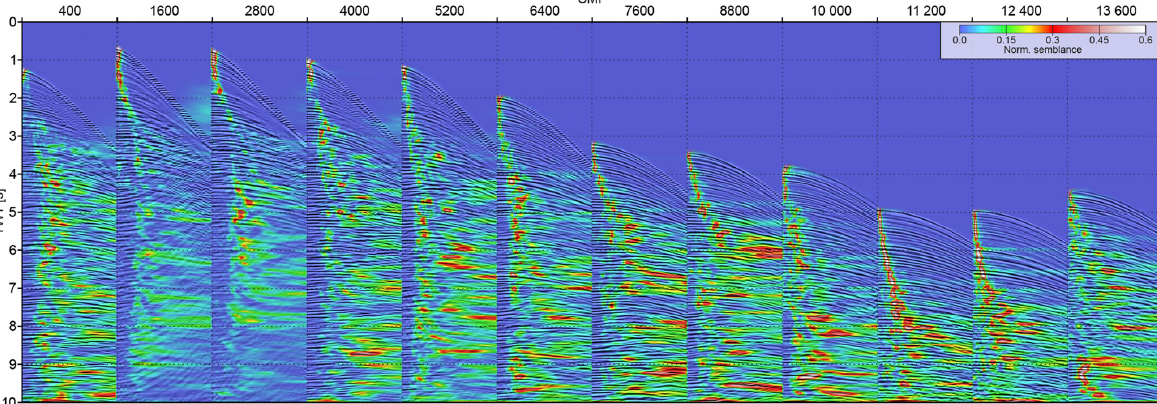
Figure 5. Results of semblance-based velocity analysis performed on the gathers presented in Fig. 2a.